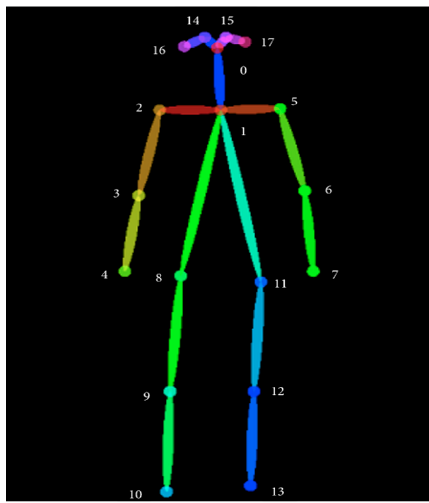
Figure 9. Feature extraction using Y_PN-MSSD model.